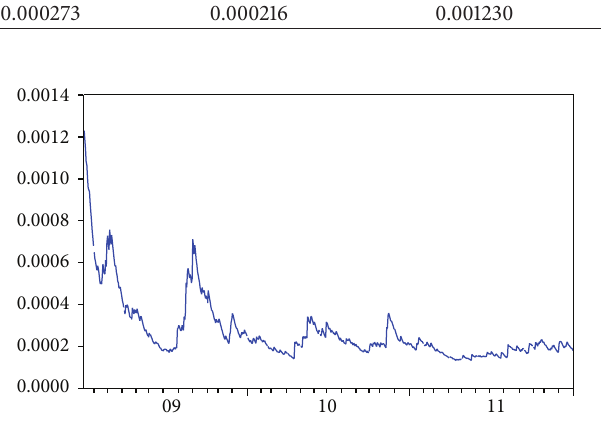
Figure 2: The conditional variance ̂ 𝜎 2 𝑚,𝑡 of comprehensive market return.